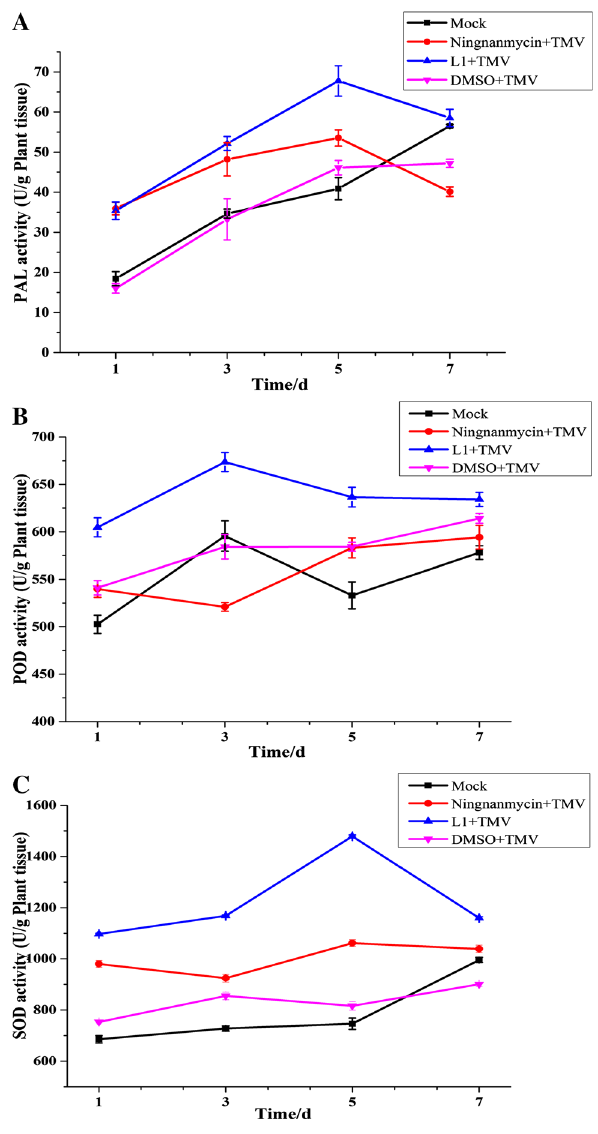
Fig. 4 PAL ( a ), POD ( b ), and SOD ( c ) activity in tobacco plants treated with compound L1 (100 l g/mL). mock, healthy tobacco; All results are expressed as mean ± SD; n = 3 for all